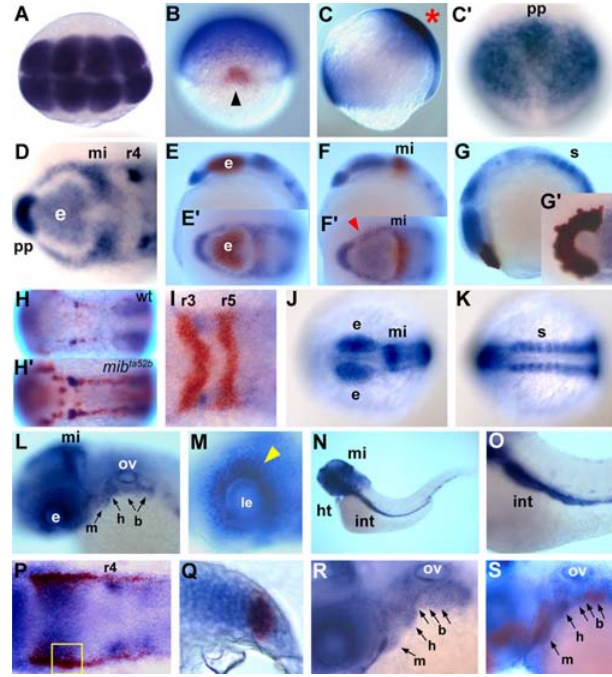
Figure 2. Detection of mych transcripts by in situ hybridization. A. Dorsal view of 8-cell stage embryo. B. Double staining of mych (blue) and gsc (red) at the shield stage; arrowhead points to the shield. C-C’. Lateral (C) and anterior dorsal (C’) views of 80% epiboly stage. Red asterisk points to the anterior-dorsal area shown in C’. D–I. 3-somite stage embryos. D. Dynamic expression of mych in the anterior brain region. E-E’. Double staining with mab21l2 (red) as a marker for eye and midbrain. F-F’. Double staining with dmbx1a (red) as marker for eye field and midbrain; red arrowhead indicates eye field. G,G’. Co- expression with ctsl1b (red), marking the prechordal plate. H-H’. Dorsal view of HuC -positive neuronal cells (red) and mych staining (blue) in wild type (H) and the mib ta52b mutant (H’). I. Rhombomeres 3 and 5 are marked by egr2b (red), while mych stains the anterior part of rhombomere 4. J–K. Dorsal views of 10-somite stage embryo showing mych expression in the eye and midbrain (J) and in trunk somites (K). L. Lateral view of mych expression in the brain and pharyngeal system at 24hpf; mandibular (m), hyoid (h), and branchial (b) arches are indicated. M. Expression of mych in the eye at the 36hpf. Arrowhead points to presumptive photoreceptor cell layer. N. mych expression in the heart and intestine (int; magnified in O) at 72hpf. P–Q. Co-expression with foxd3 (red) at the 4-somite stage. The yellow open square area in P is shown as a section in Q. R–S. Pharyngeal arch marker dlx2a (red in S) is co-expressed with mych at 32hpf. b, branchial arch; e, eye; h, hyoid arch; ht, heart; int, intestine; le, lens; m, mandibular arch; mi, midbrain; ov, otic vesicle; pp, prechordal plate; r, rhombomere; s, somite.